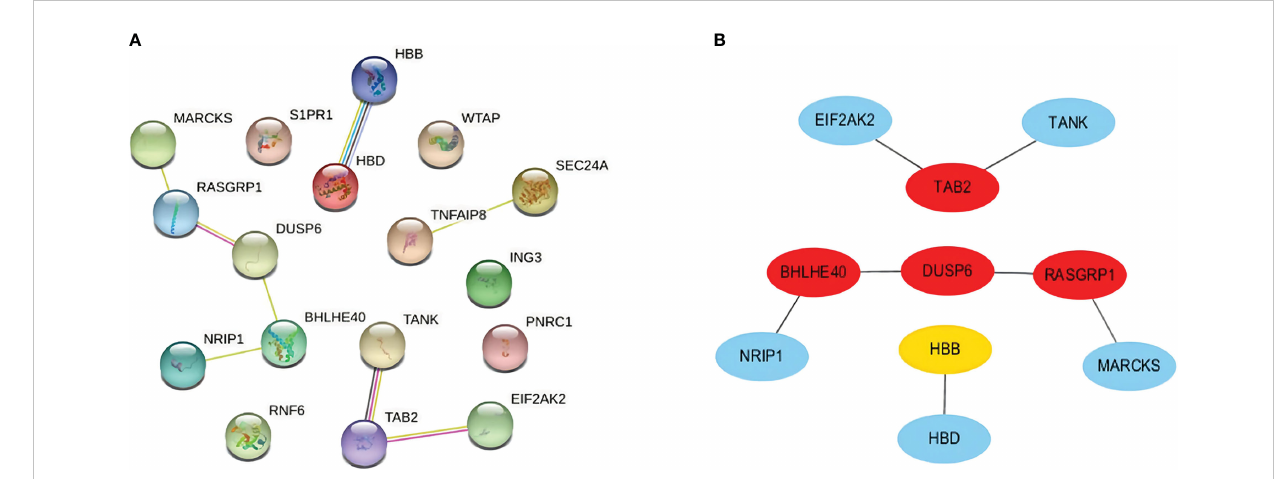
FIGURE 5 (A) PPI network with nodes representing DEGs and edges representing interactions between nodes among SARS-CoV-2, AKI, and CKD. (B) Determination of hub genes from the PPI network by using the cytoHubba plugin in Cytoscape. The latest MCC procedure of the cytoHubba plugin was pursued to obtain hub genes. Here, the red nodes indicate the highlighted top 4 hub genes and their interactions with other molecules. PPI, protein – protein interaction; DEGs, differentially expressed genes; SARS-CoV-2, severe acute respiratory syndrome coronavirus 2; AKI, acute kidney injury; CKD, chronic kidney disease; MCC, maximal clique centrality.